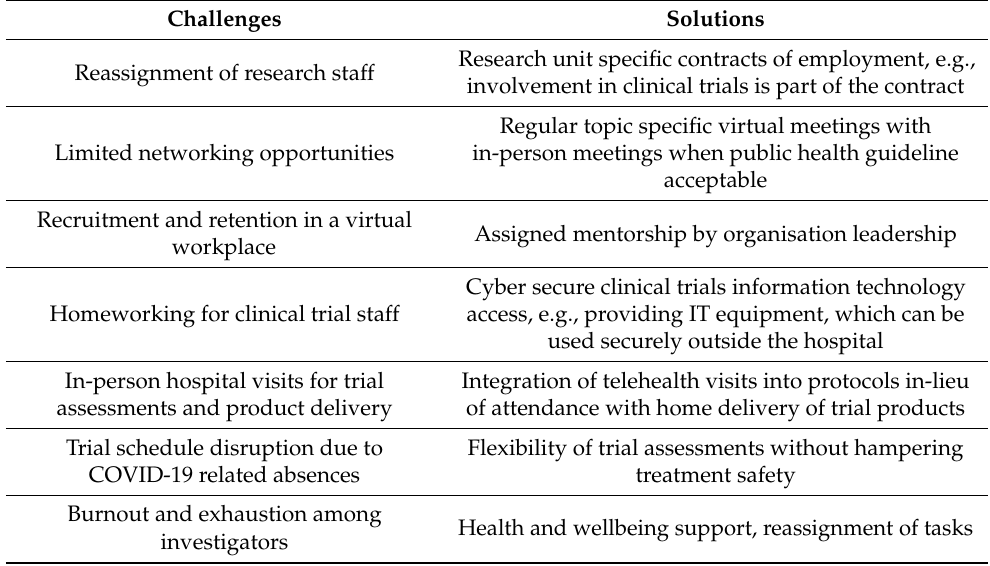
Table 3. COVID-19 associated challenges and solutions to clinical trial